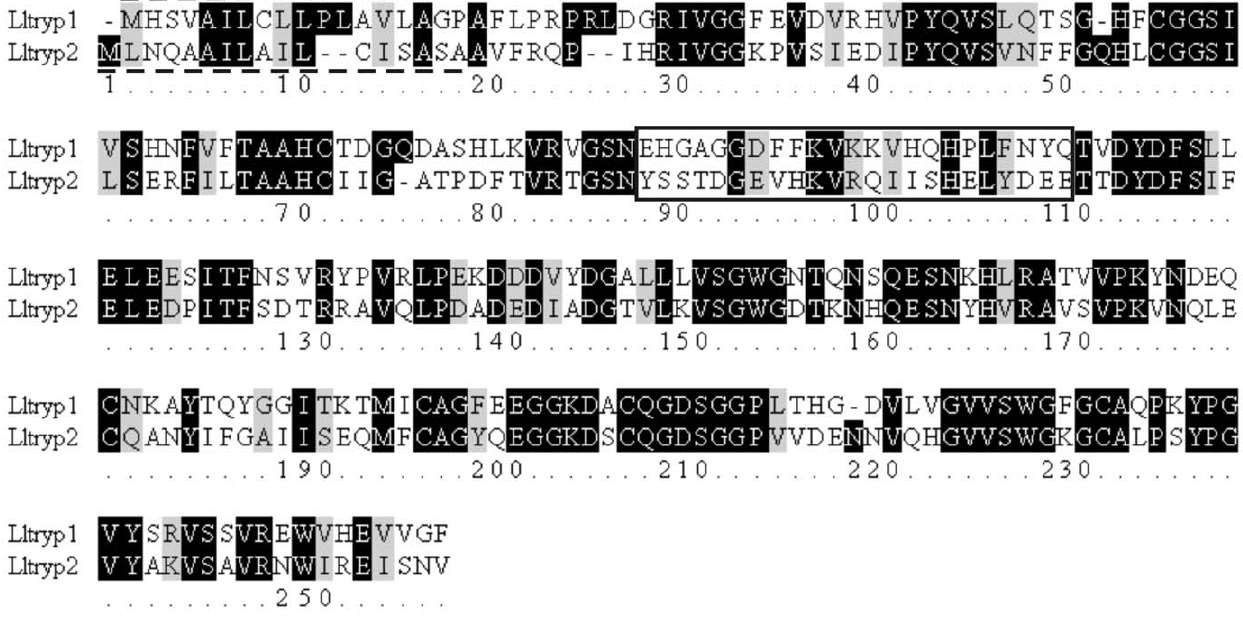
Figure 1. Alignment of deduced amino acid sequences of L.longipalpis trypsins (Lltryp1 and Lltryp2). Conserved residues are shown as white letter on black background. Non-conserved residues are shown as black letters on a white background. Black letters on gray background indicate conserved substitutions. The predicted secretory signal peptides for Lltryp1 (residues 2–17) and Lltryp2 (residues 1–19) are indicated by a traced line. Lltryp1 and Lltryp2-specific peptides used for immunization procedures are boxed (residues 89 to 111).